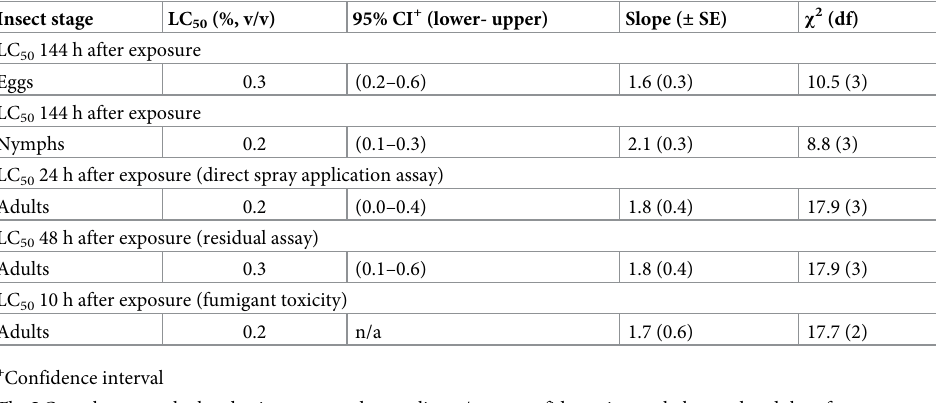
Table 3. Comparative lethal median concentration (LC 50 ) values of methyl benzoate (MB) for Bemisia tabaci eggs, nymphs, and